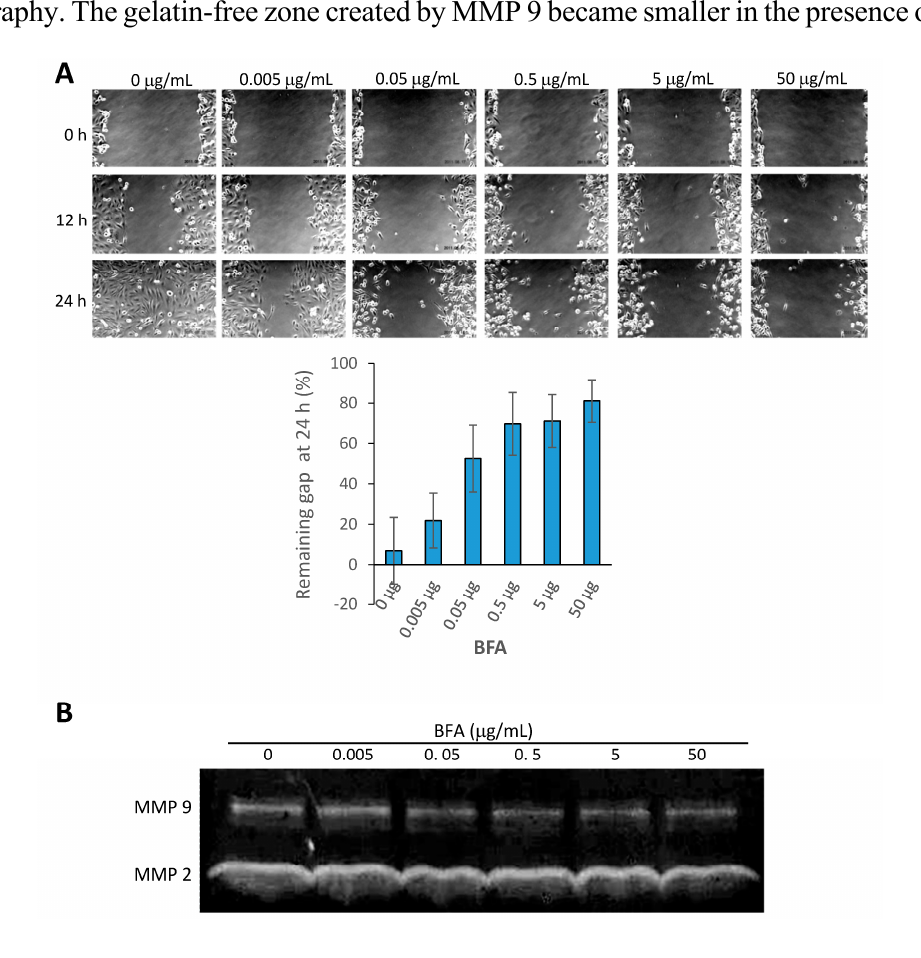
Figure 3. BFA inhibited the migration and MMP 9 activity of MDA-MB-231. ( A ) Wound healing assay was used to assess the inhibitory effect of BFA on MDA-MB-231 migration. Quantitative analysis showed BFA at concentrations ≥ 0.05 μ g/mL significantly increased the remaining gap at 24 h. ( B ) MMP activities in the concentrated conditional media